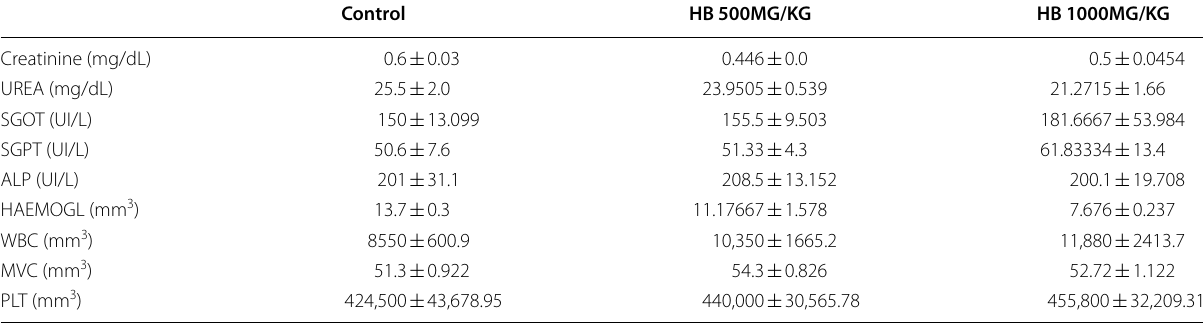
Table 6 Results of biochemical and hematological parameters